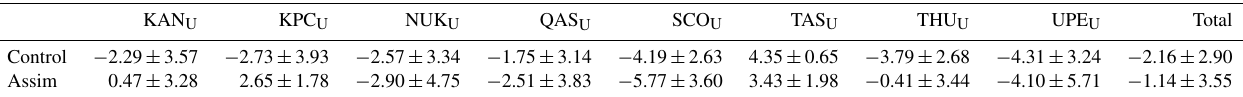
Figure 11. Mean monthly surface temperature for May 2012 from the control (a) and updated simulation experiment (b) along with the anomaly (c) . Table 5. Mean bias and standard deviation of errors for the control simulation and the one using the assimilation of the L4 IST against the individual PROMICE stations for May